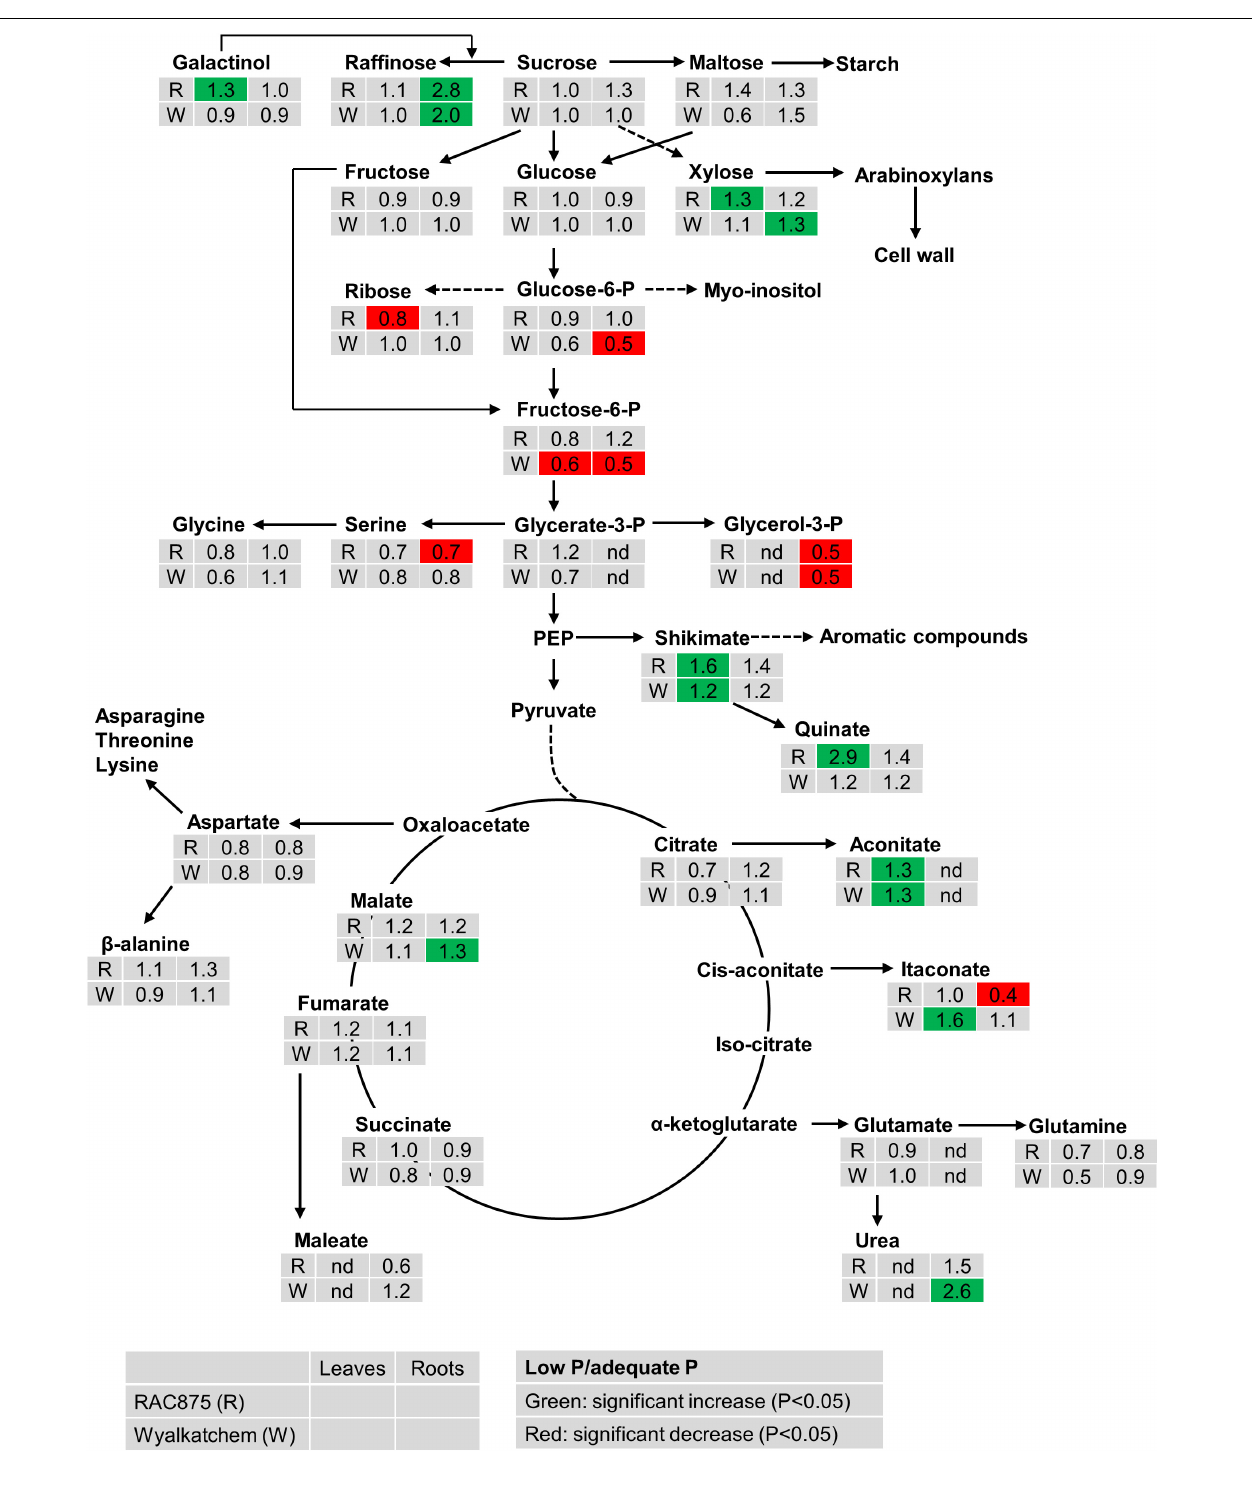
FIGURE 1 | The effect of P supply on the levels of metabolites from shoots and roots of two wheat genotypes RAC875 (the upper row) and Wyalkatchem (the lower row) at 28 days after sowing (DAS). Plants were grown in sandy soils at low (10 mg P kg − 1 soil) and adequate (30 mg P kg − 1 soil) P supply. Relative ratios (low P/adequate P) in shoots (the first column) and in roots (the second column) are presented as means of four biological replicates. Significant increases ( P < 0.05) are indicated in green and significant decreases ( P < 0.05) are indicated in red; nd: not detectable.